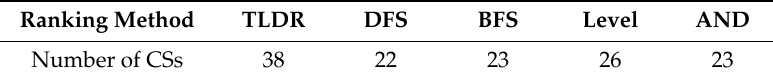
Table 2. Number of cut-set about the FT from Figure